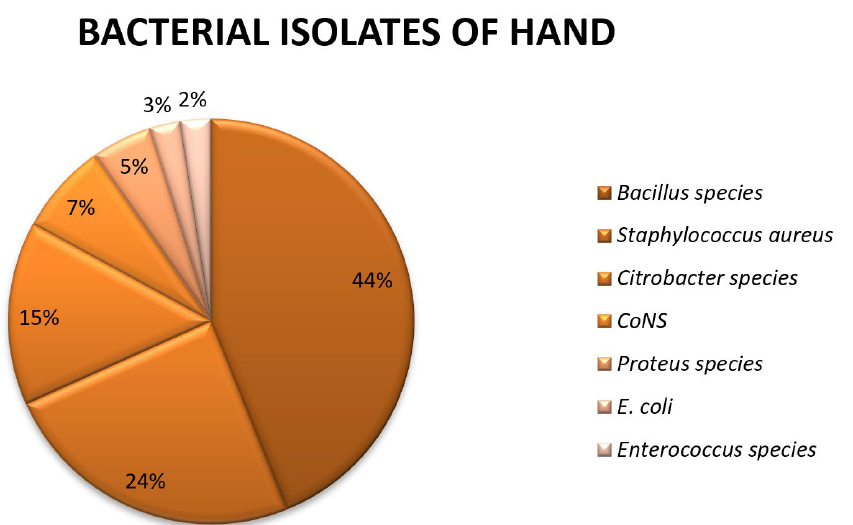
Fig. 2. Distribution of bacterial isolates from hands of food handlers